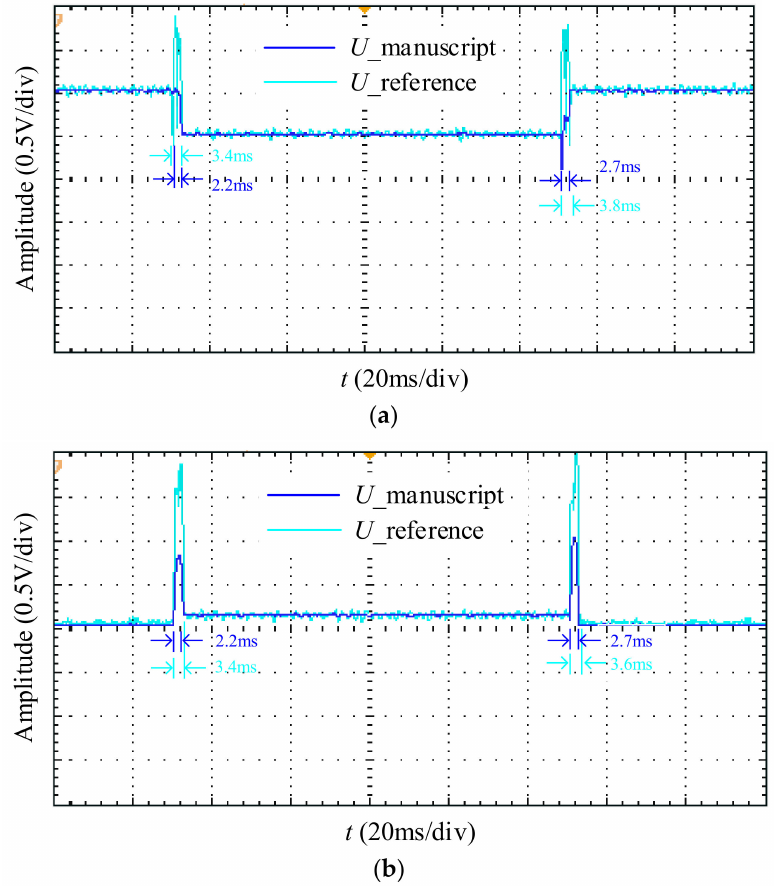
Figure 16. Comparison of positive-sequence and negative-sequence voltage amplitude detection results in hardware-in-the-loop test; ( a ) positive-sequence component; ( b ) negative-sequence